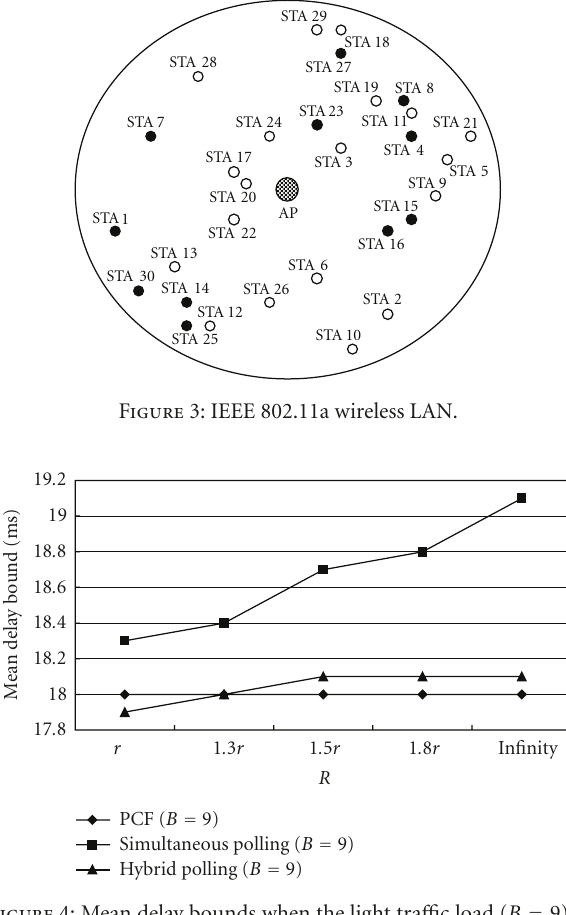
Figure 4: Mean delay bounds when the light tra ffi c load ( B = 9) is imposed on IEEE 802.11a wireless LAN with 20